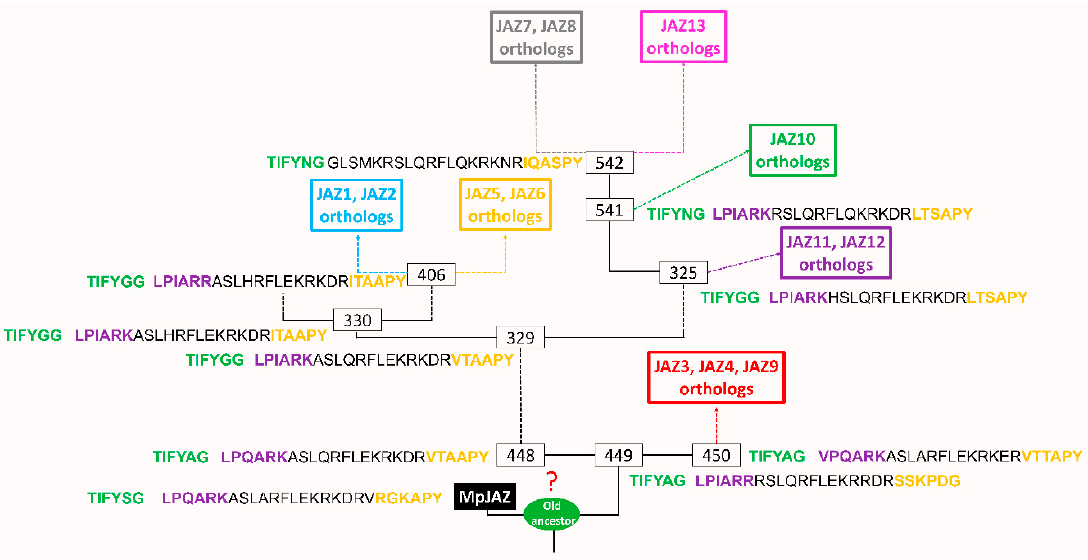
Figure 8. Proposed model of JAZ protein evolution. Numbers framed in boxes indicate the output name of the ancestor assigned by the PhyloBot software. The analysis of JAZ ancestral sequences is available to download at the following URL: http://www.phylobot.com/464456268, last accessed date: 19 August 2019. The TIFY motif and the Jas domain are displayed near to each ancestor. Di ff erent colors in boxes show di ff erent subgroups of eight JAZ ortholog proteins. Dashed lines indicate intermediate ancestors. The length of branches does not correspond to evolution time. JAZ, jasmonate-ZIM